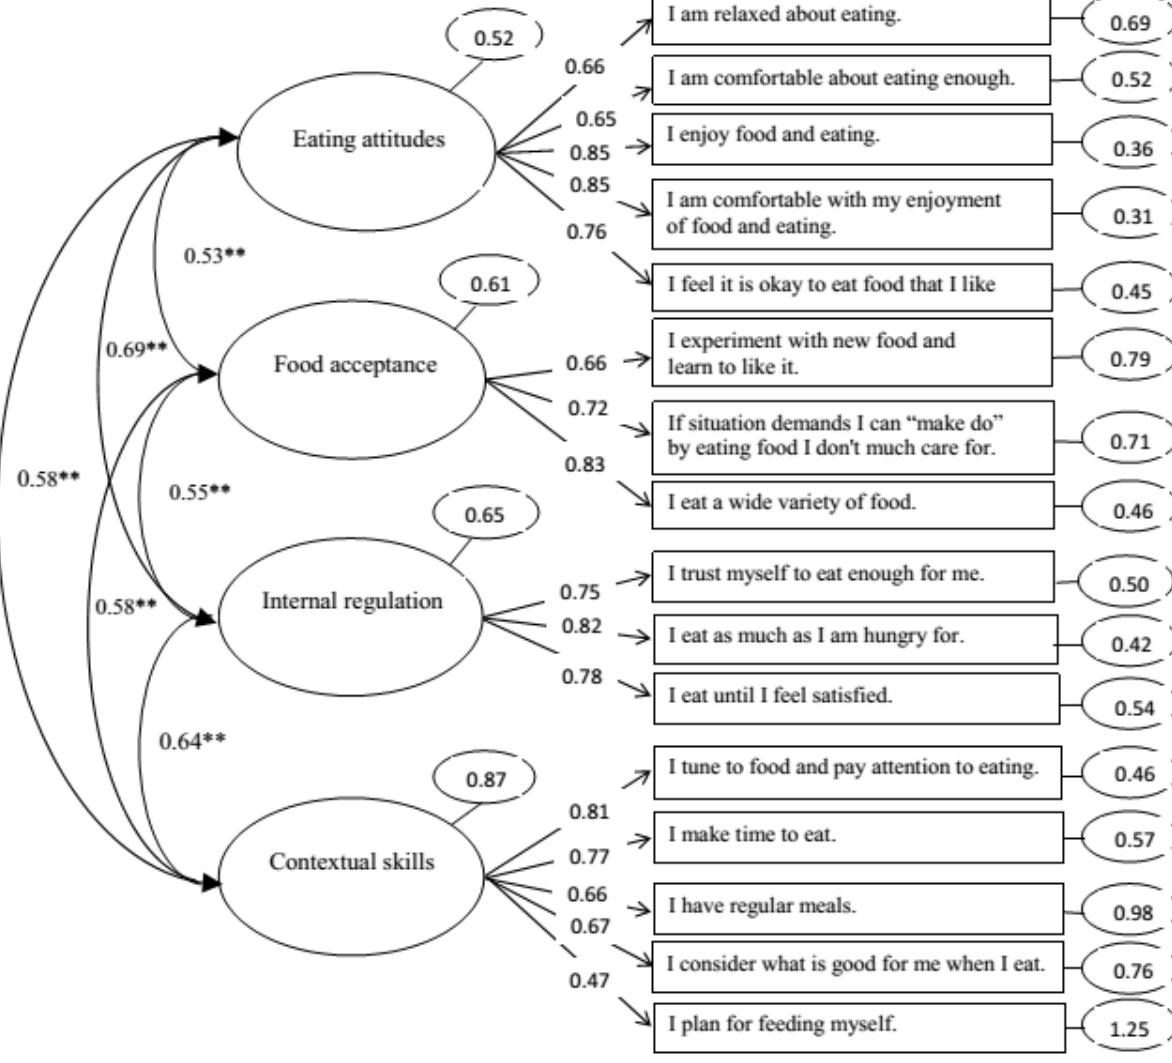
Figure 2. Measurement model (confirmatory factor analysis (CFA)) of the preliminary Finnish translation of ecSatter Eating Competence Inventory 2.0 (ecSI 2.0) ( n = 976). Two-headed arrows between ellipses represent correlations between ecSI 2.0 main